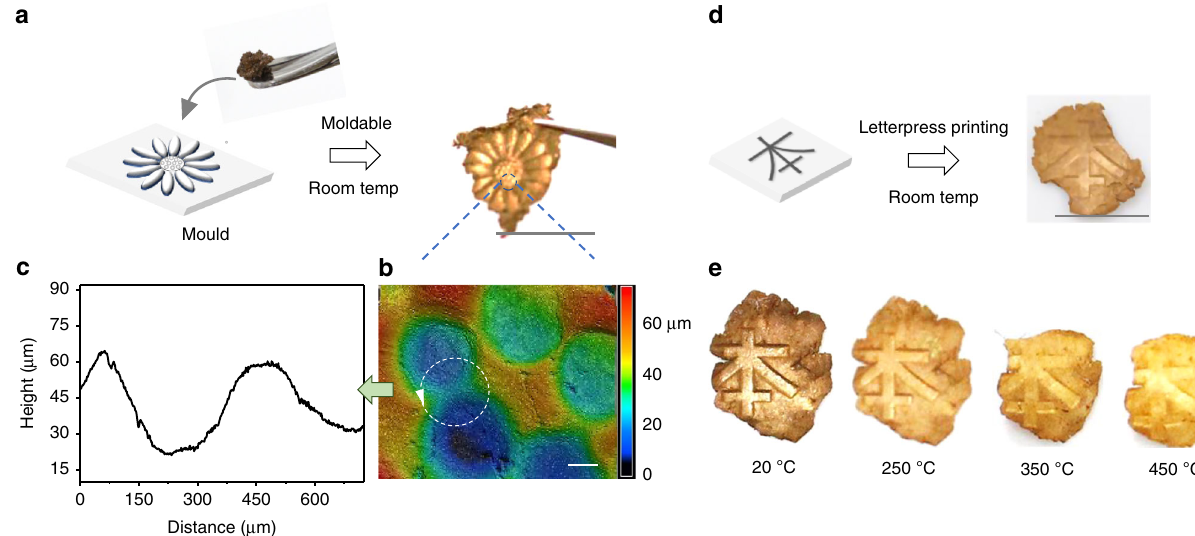
Fig. 5 Mouldable gold metal clay. a Demonstration of a free-standing moulded shape from the gold nanosheet aggregates at room temperature. b Surface 3D height maps of the structure in the circled area from ( a ). c The corresponding surface pro fi les along the white dashed lines in ( b ). d Demonstration of macroscale moulded characters from gold clay at room temperature and e annealing of the deformed shape under high temperatures. Scale bars: a 1.0 cm; b 100 μ m; d 1.0 Stress-dependent conductivity and morphology change . In strain were precisely controlled by a tensile machine. Before and addition to plasticity, mouldability, and stress/strain or after every pressing (without any thermal treatment), the surface temperature-induced hardening, the gold clays are highly con- resistance values were measured by the four-probe method with a ductive (Supplementary Movie 3). The detailed resistance and low resistivity metre (Loresta-AX MCP-T370 Mitsubishi Electric) electrical resistivity ( ρ ) values are shown in Fig. 6a, b. The gold at room temperature. The electrical resistance value ( ρ ) decreased clay was deformed into a square-shaped sample, and changes in from ~5 × 10 − 5 Ω m (as-prepared state, thickness: 1.17 mm) to